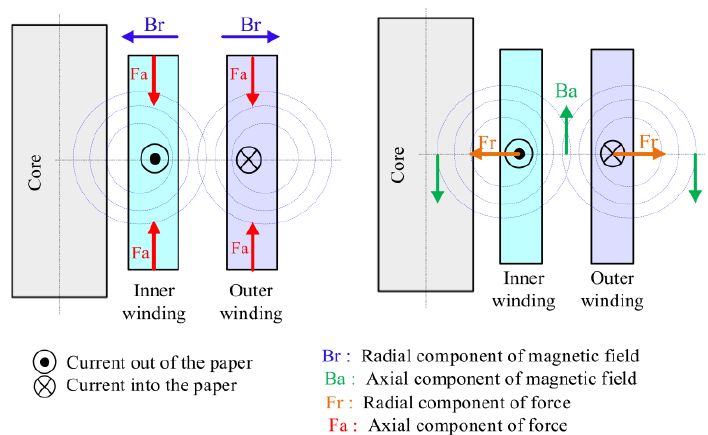
Figure 14. Axial ( left ) and radial ( right ) electromagnetic forces generated by the interaction of windings current and leakage flux.